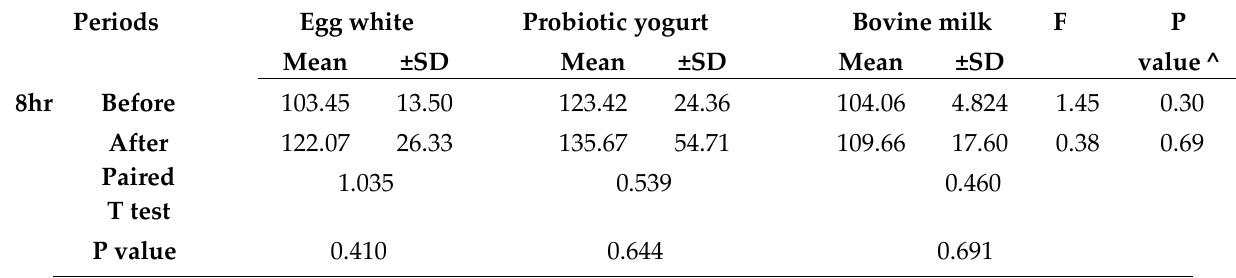
Table 7 : Descriptive and statistical test of granularity diameter among storage media and periods .